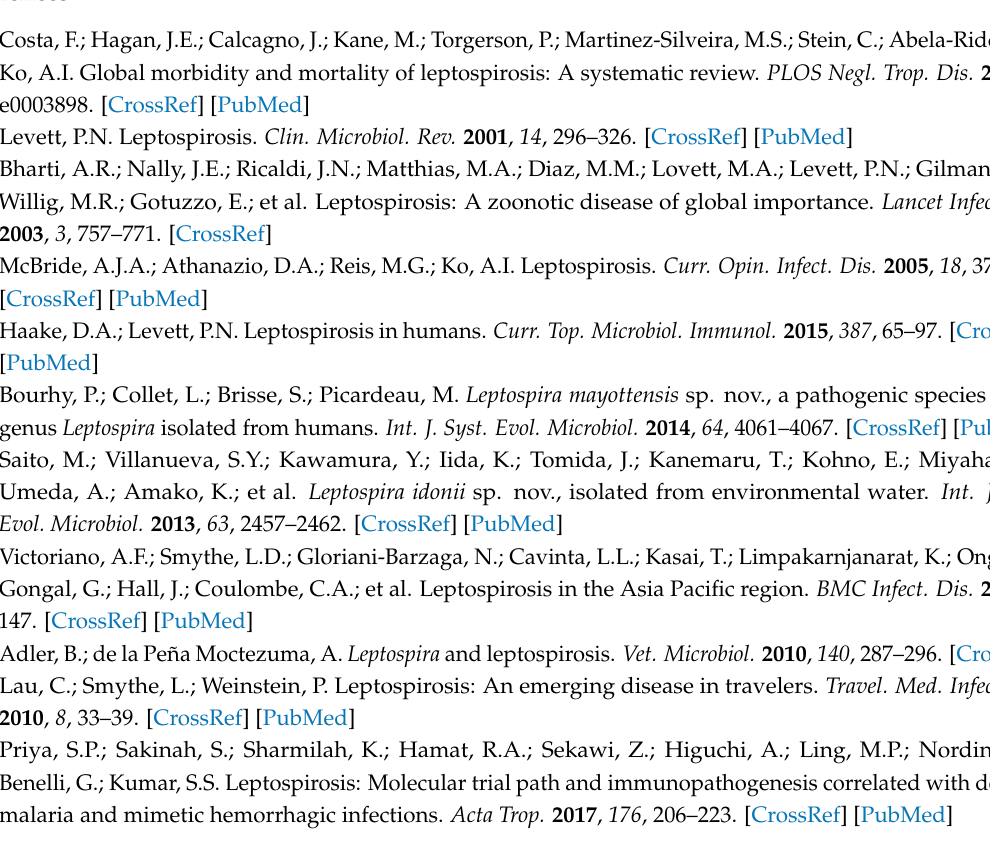
Table S1: Socio-demographic characteristics of members of a rural community in this study; Table S2: Sources from which members of a rural community obtained the information on leptospirosis; Table S3: Knowledge level of leptospirosis in relation to socio-demographic variables; Table S4: Practices of rural communities relating to prevention of leptospirosis and its socio-demographic variables; Table S5: Multiple logistic regression predicting the knowledge level on leptospirosis; Table S6: Multiple logistic regression predicting the practices level on leptospirosis; Table S7: Association between preventive practices level and knowledge level and attitude of the rural communities related to leptospirosis; Table S8: Multiple logistic regression of knowledge and attitude predicting the practices level on